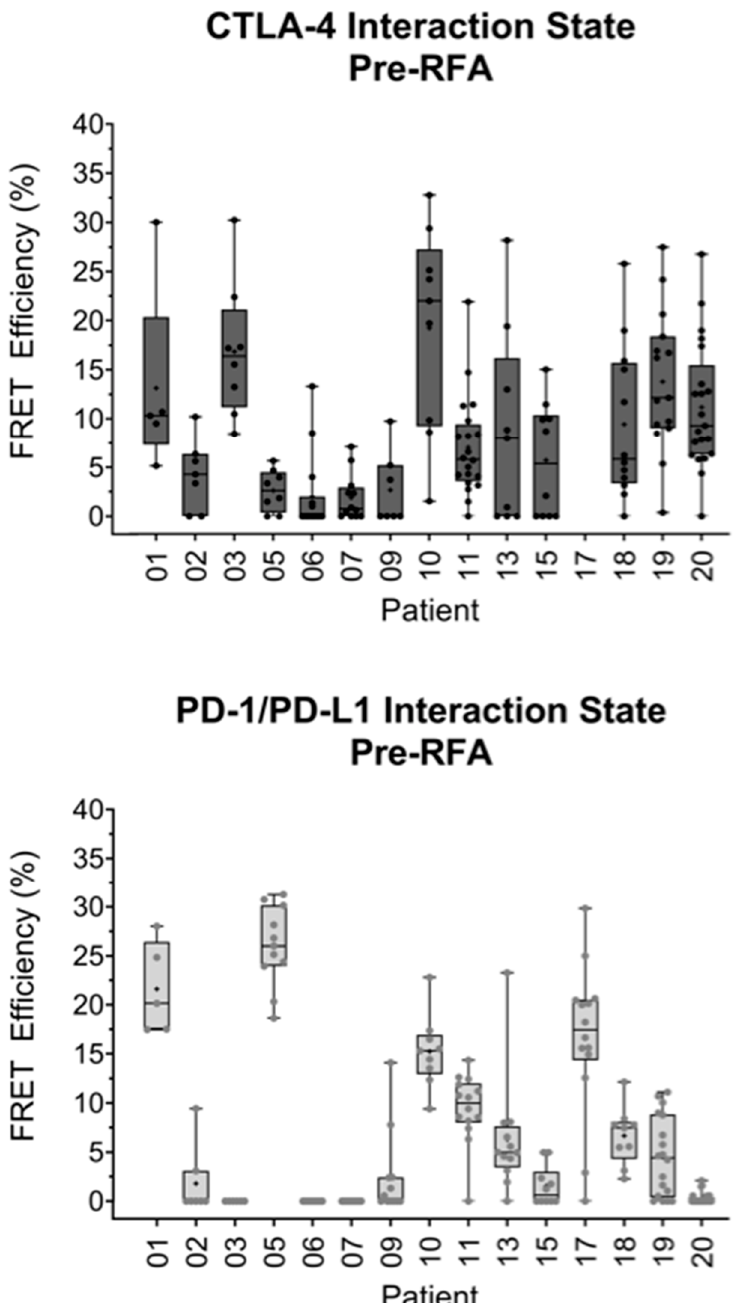
Figure 2. iFRET detects intra- and intertumoral heterogeneity in both CTLA-4/CD80 and PD-1/PD- L1 interactions in metastases from lung one (pre-RFA). Box and whisker plots show the statistical distribution of all interaction states recorded for CTLA-4/CD80 (top panel) and PD-1/PD-L1 (bottom panel) in metastases taken from lung one, before RFA was carried out. Each point represents one region of interest for an analyzed patient sample. Note, no data were analyzed for CTLA-4/CD80 interactions in patient 17 due to poor a poor signal-to-noise ratio. Interaction states are generally higher in CTLA-4/CD80 than PD-1/PD-L1 with two patients having no PD-1/PD-L1 interaction across the sample. Some patients have differential interaction profiles for the two pathways. Patient 05 has a low CTLA-4/CD80 interaction and high PD-1/PD-L1 interaction. A contrasting trend is seen in patient 20, who has a significantly higher CTLA-4/CD80 interaction state than PD-1/PD-L1. Some patients, such as patient 13, showed no significant differences between CTLA-4/CD80 and PD-1/PD-L1 interaction